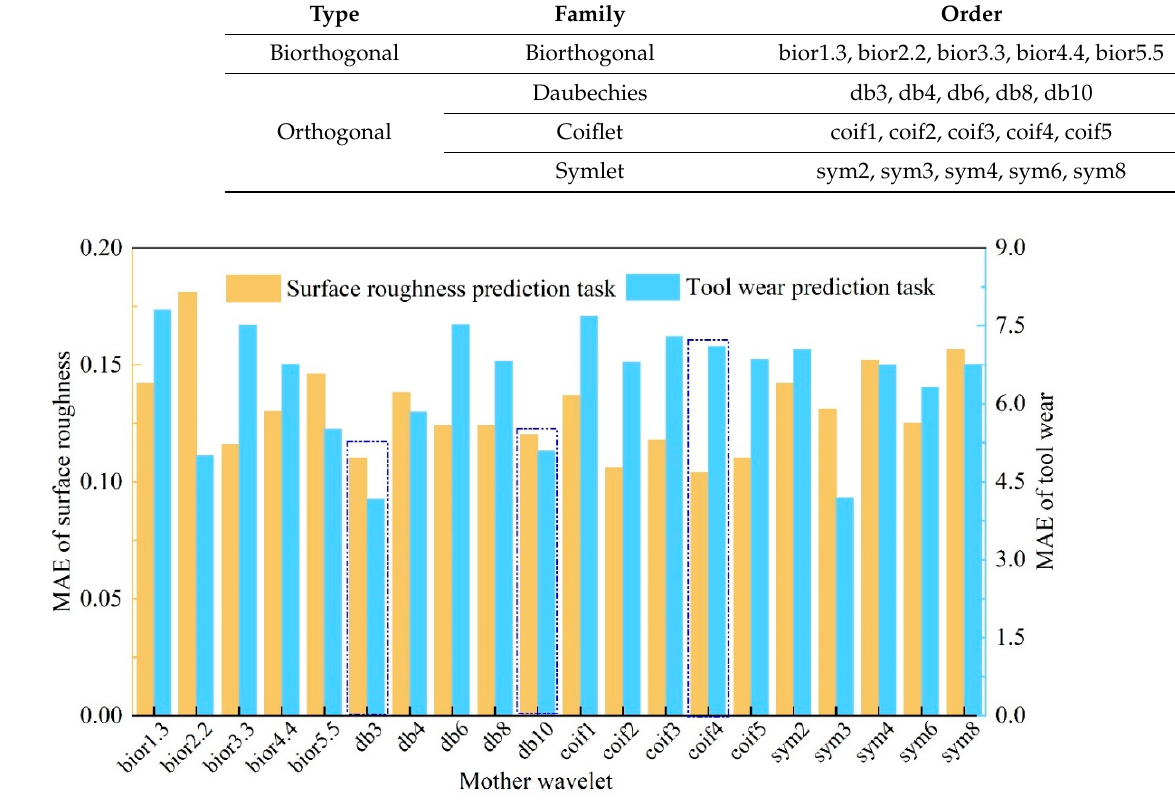
Figure 14. The performance of different mother wavelets.